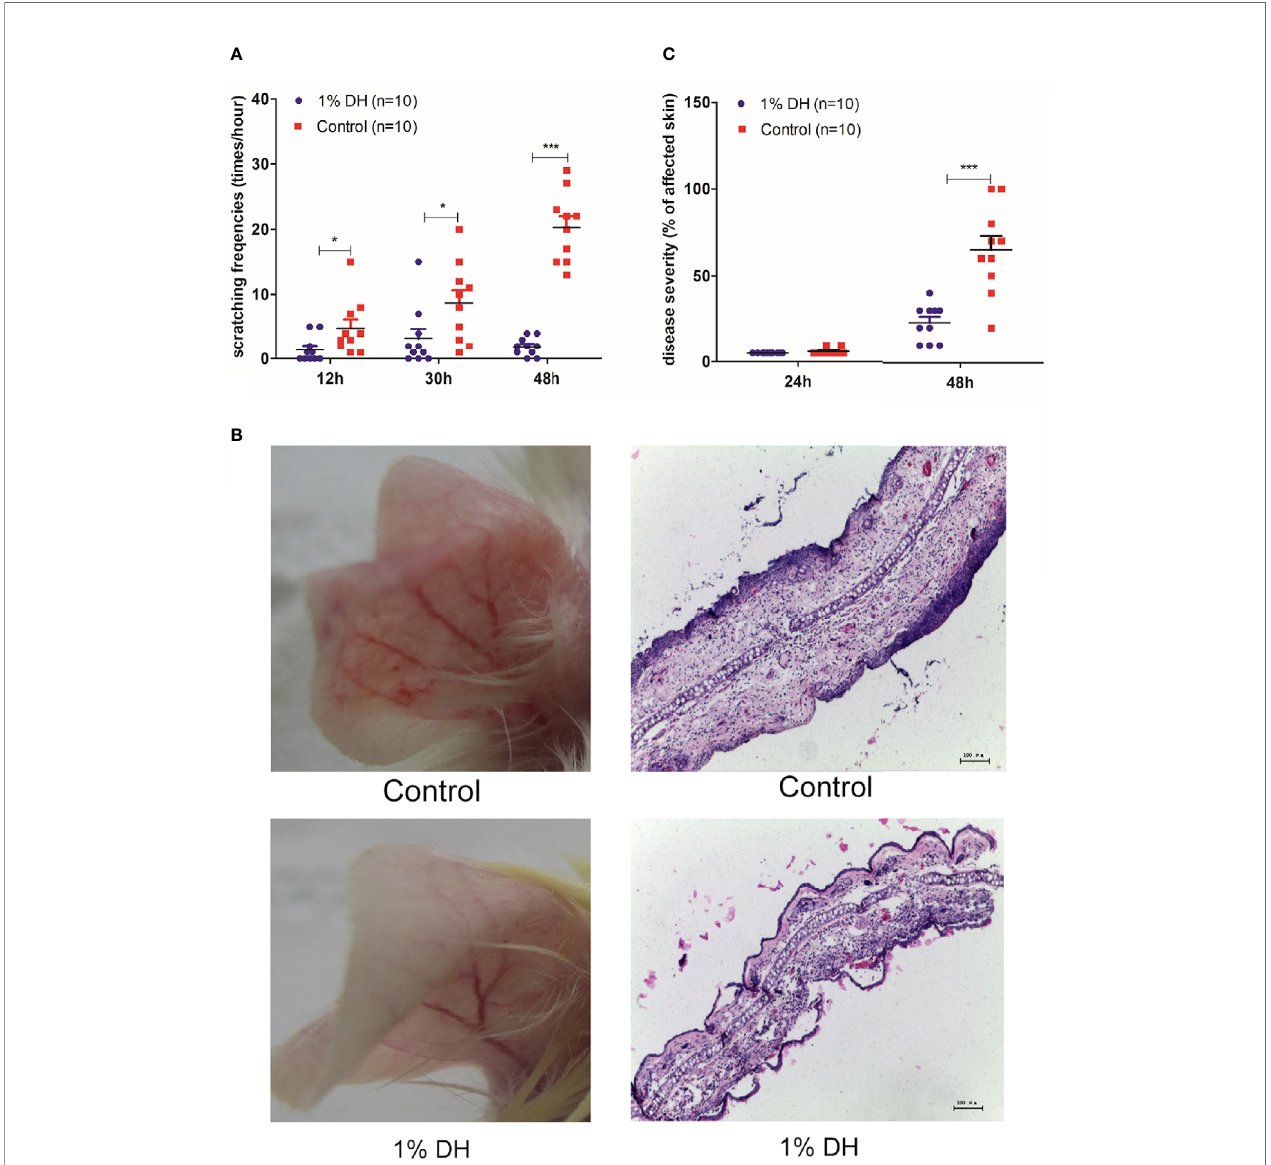
FIGURE 2 | Preventive topical application of dyclonine inhibited scratching and impaired clinical disease manifestation in antibody transfer-induced EBA. Immediately before the injection of anti-mCOL7 IgG, 1% dyclonine or solvent was applied topically onto mouse ears, and such application was maintained every six hours until the end of the experiment. (A) Effect of dyclonine hydrochloride on scratching behaviour at 12, 30 and 48 h after the injection of anti-mCOL7 IgG. (B) Representative pictures of ear skin lesions and histology in mice injected with rabbit anti-mCOL7 IgG and treated with dyclonine hydrochloride or control solvent. (C) Effect of dyclonine hydrochloride on disease severity at 24 and 48 h after the injection of antibodies. This fi gure shows representative results of one of three independent experiments each performed with 5 mice (10 ears) per experimental group. Bars = 100 m m. Signi fi cant differences as determined by unpaired student t test between anti-mCOL7 IgG-treated ears and control IgG-treated ears are indicated (* p < 0.05; *** p <